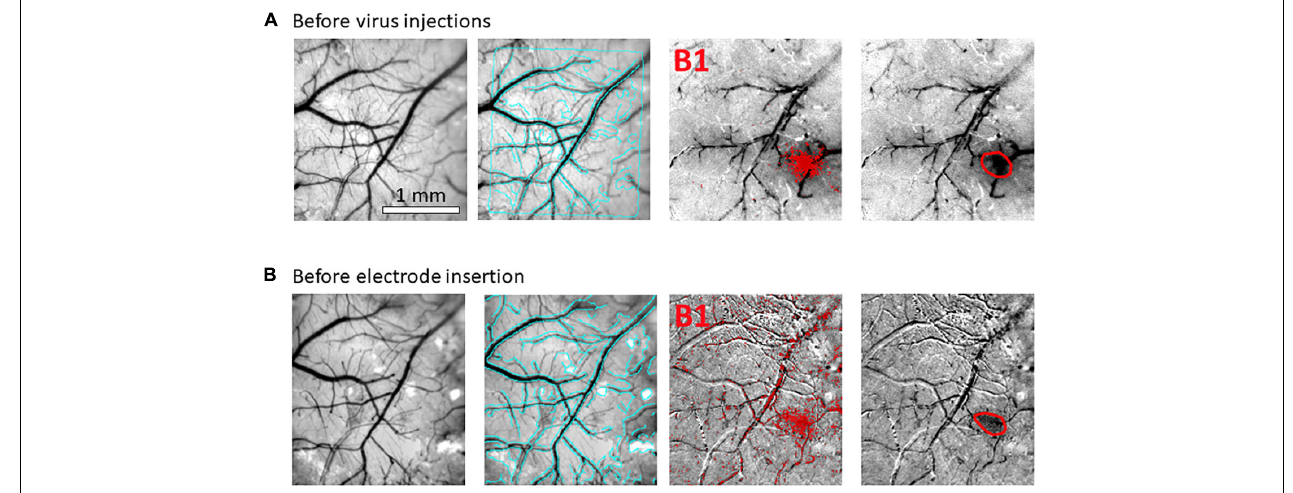
FIGURE 2 | Hemodynamic responses to single-whisker piezoelectric stimulations. (A) OI-IS through the thinned skull for guiding microinjections. The 2 left-most panels shows an image of the surface of cortex, taken under green light illumination (peak wavelength of 530 nm) at the beginning of the experiment to obtain the pial vessel topography. The cyan curves are edges of the pial vessels computed before the insertion of the electrode (second panel in B ) and superimposed on the pial vessels image before the injections, for demonstrating the alignment of the imaged regions and responses. The third panel presents the hemodynamic response to single whisker (whisker B1) stimulation, averaged over 10 trials. Pixels with superimposed red dots showed statistically significant responses. The fourth column shows the perimeter encompassing the responding region, obtained by computing the convex hull around all clusters of connected responding pixels that showed statistically significant response. (B) OI-IS following a craniotomy, for guiding the insertion of the recording electrode and the positioning of the optic fiber. All four panels are identical in scope to those presented in (A) . The cyan colored curves present the edges of the pial vessels computed (using Canny edge detection) from the green image obtained before electrode